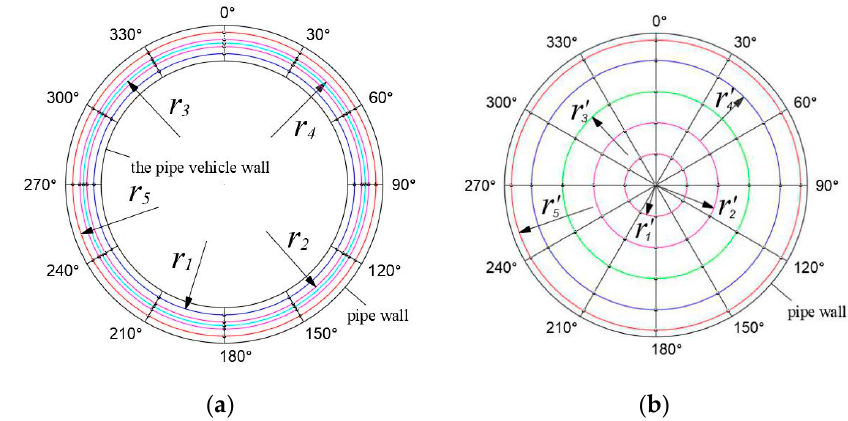
Figure 8. Schematic of measuring point layout. ( a ) Arrangement of measuring points in the annular gap. ( b ) Arrangement of measuring points in the vehicle spacing. Note: r 1 ~ r 5 are the radii of the measuring rings in the annular gap; r 1 ′ ~ r 5 ′ are the radio of the measuring rings in the vehicle spacing.